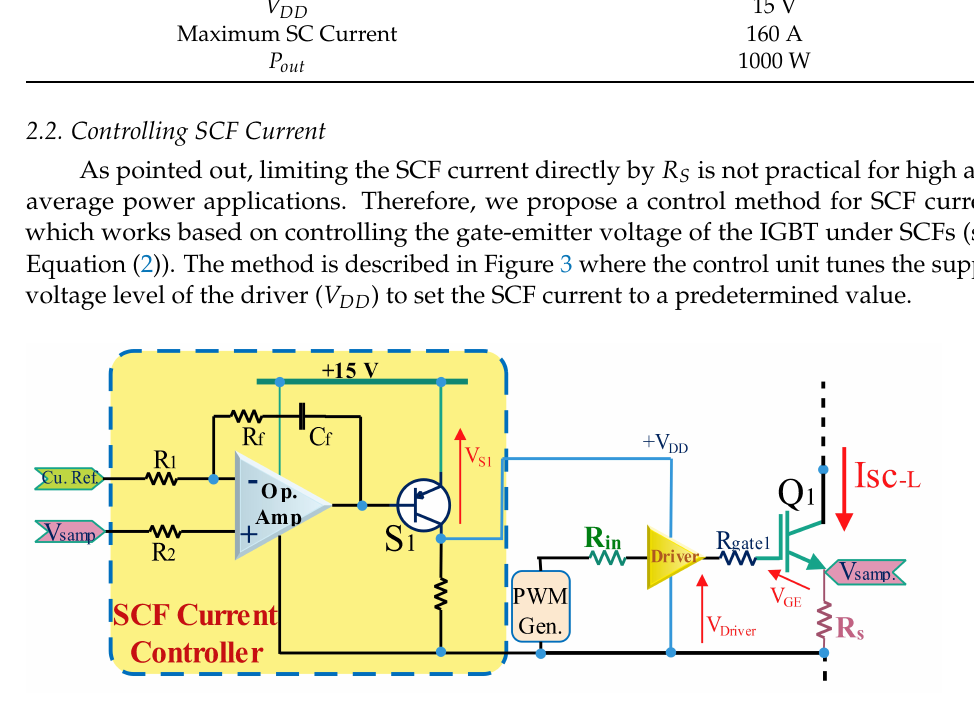
Figure 3. The schematic overview of the SCF current controlling